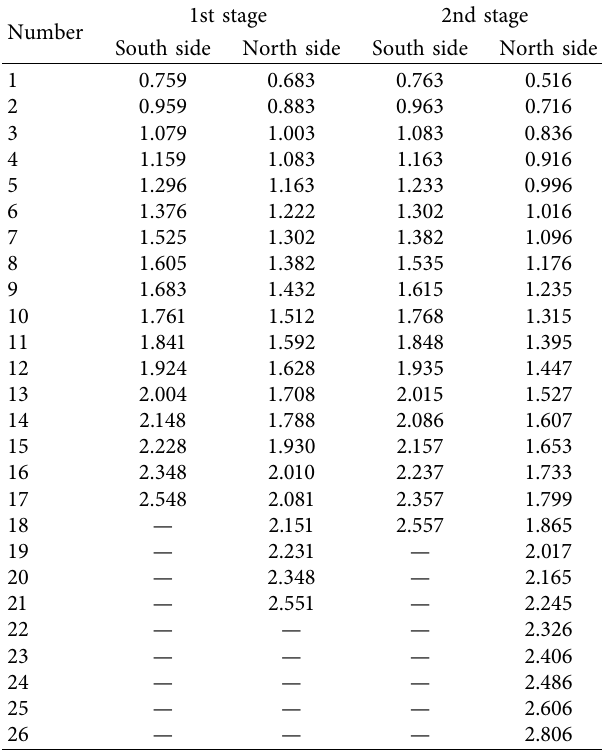
Table 3: Distances of the selected key sections to the left support of the beam B1 (unit: